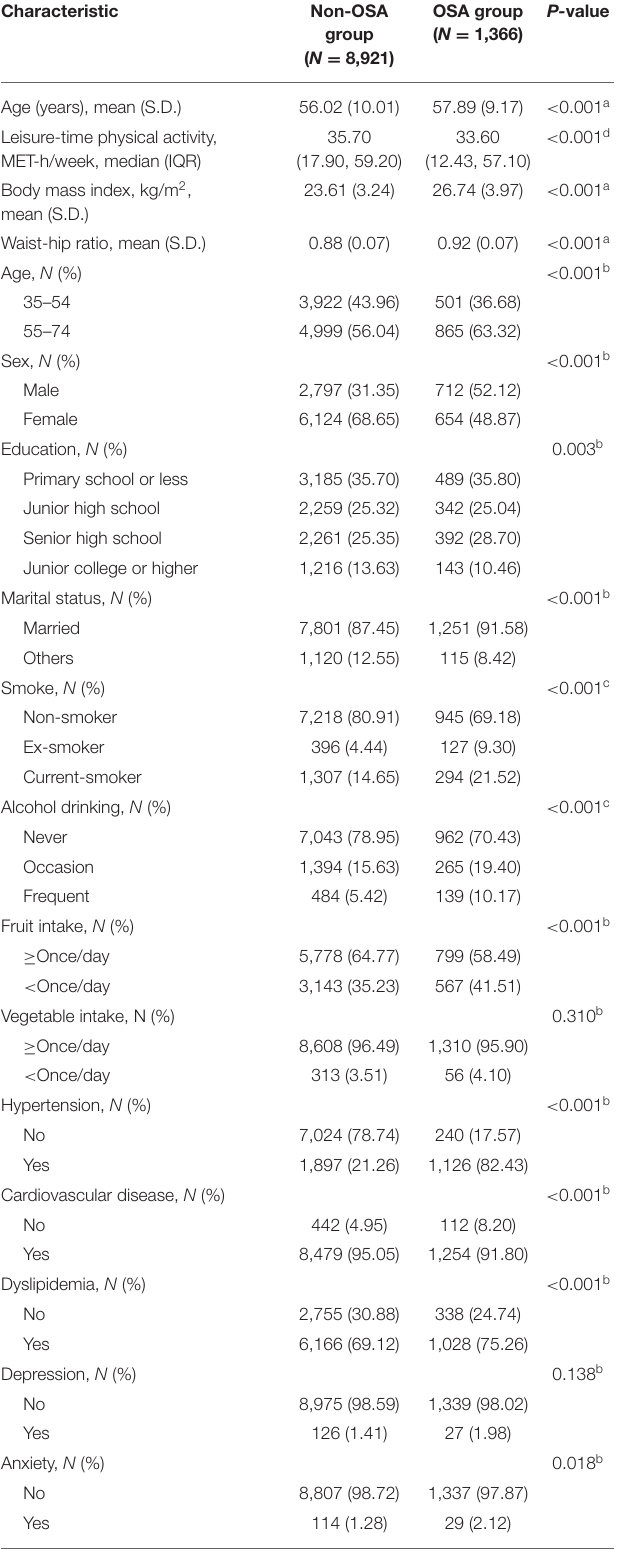
( Supplementary Figure 2 ). Unadjusted and adjusted odds ratios (OR) with 95% confidence intervals (CI) were estimated by using logistic regression. Given the depressive and anxiety symptoms often co-occurred, we estimated the association of combined exposure of depression and anxiety with OSA